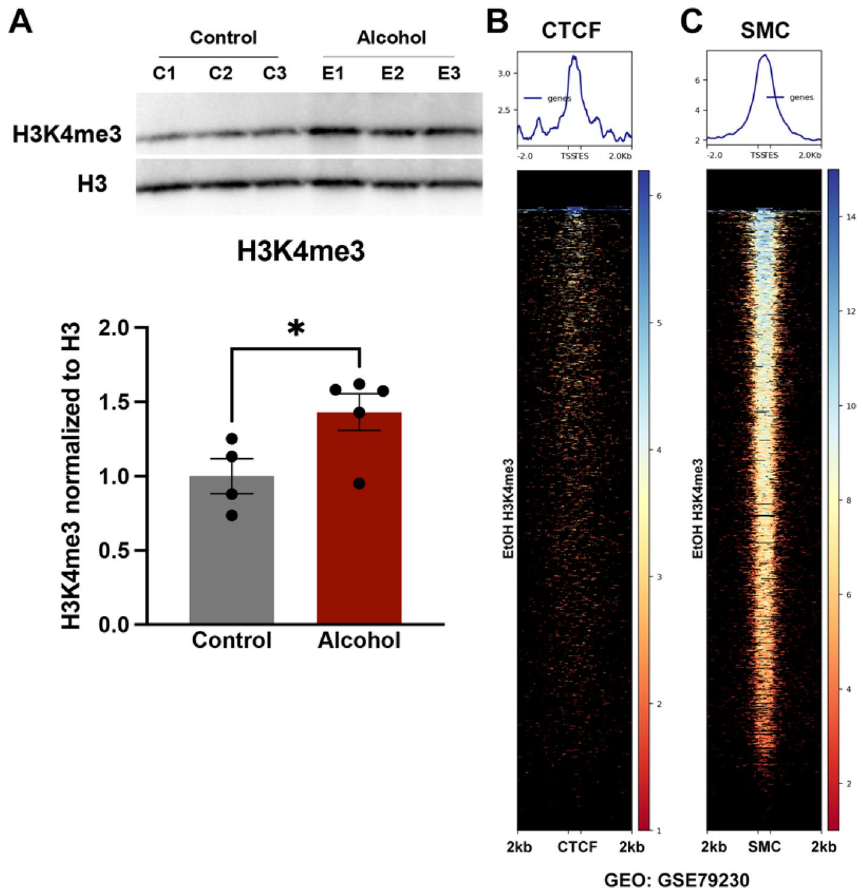
Figure 2. Increased H3K4me3 in sperm derived from EtOH-exposed males maps to CTCF and SMC-bound regions of the sperm genome. ( A ) Western blot analysis comparing total H3K4me3 normalized to histone H3 between preconception treatment groups (n = 4 control, 5 EtOH). Heatmaps displaying enrichment of EtOH- induced H3K4me3 signals across ( B ) CTCF- and ( C ) SMC-bound loci, previously identified in sperm (Jung et al. 2017, Geo: